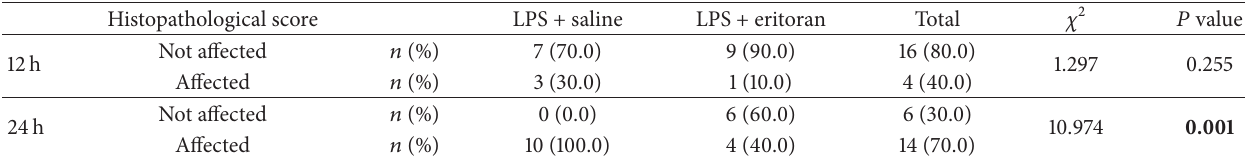
Table 3: Relabeled statistical analysis of histopathological